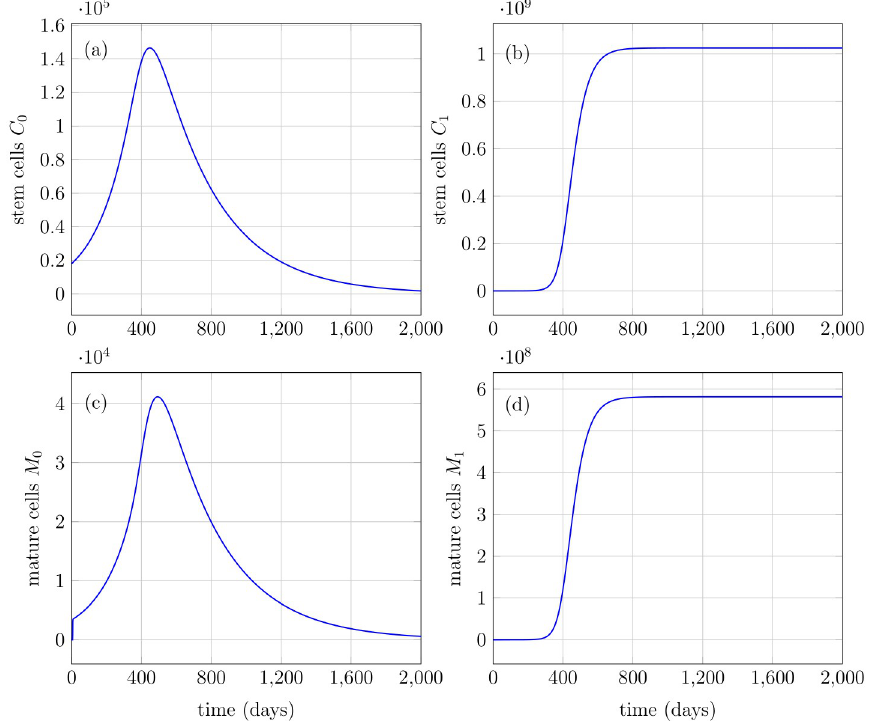
Fig 6. Number of healthy and mutated stem and mature cells. (a) Healthy stem cells with initial value of 18000 mL − 1 grow exponentially and start decreasing in number. (b) Mutated stem cells with initial condition equal to zero, increase exponentially until attain a steady-state at relatively large value. (c) Healthy mature cells with initial condition equal to zero, depict the same behavior as healthy stem cells. (d) Mutated mature cells depict a similar behavior as mutated stem cells with initial condition equal to zero.